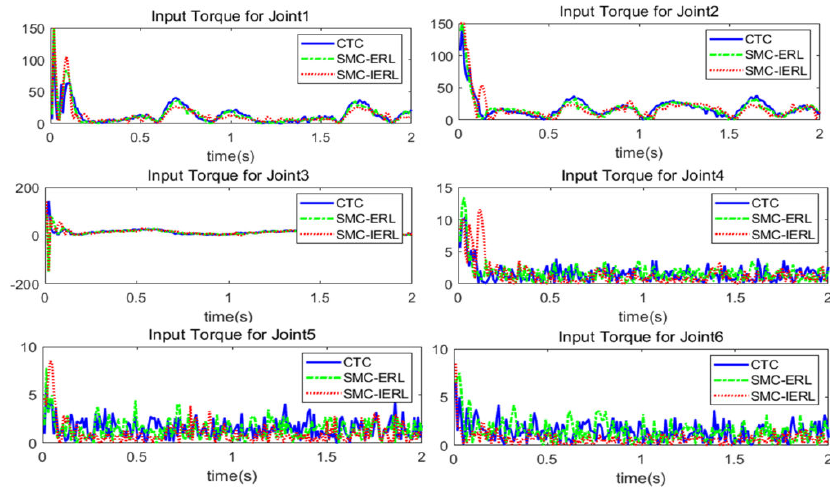
Figure 8. In the uniform circular trajectory experiment with disturbance signal, the output torque of each joint obtained by the three control algorithms is compared.